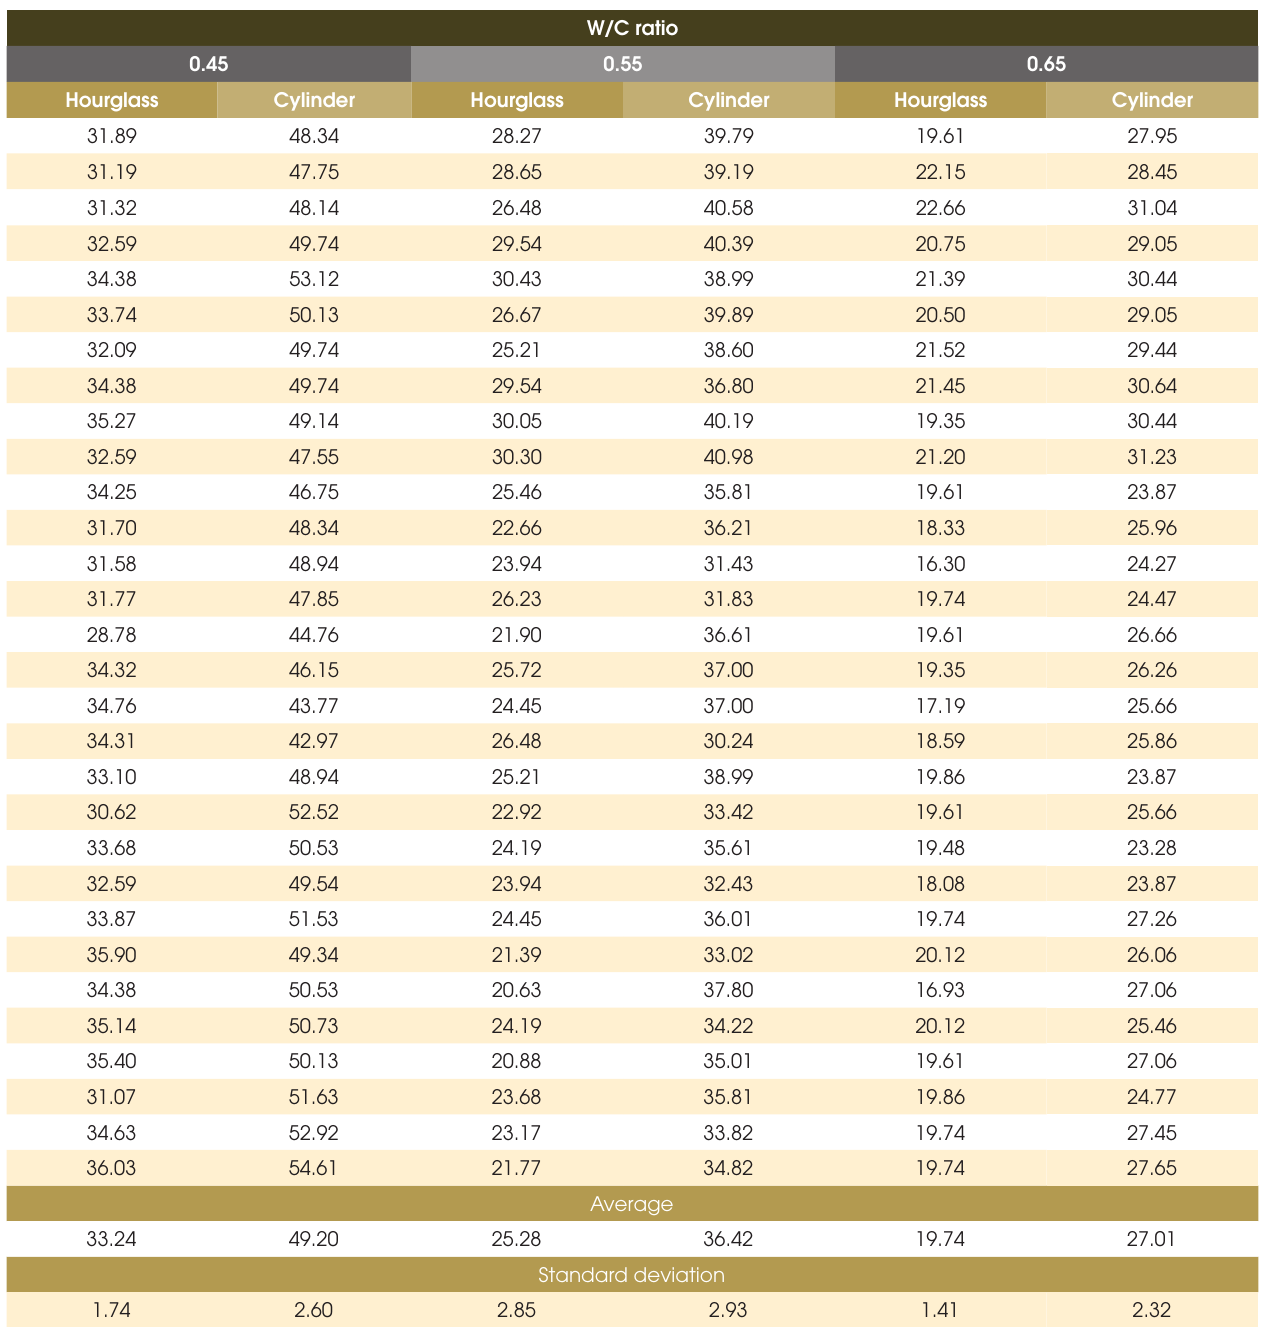
Table 5 – Results of compressive strength of cylinders and hourglass specimens